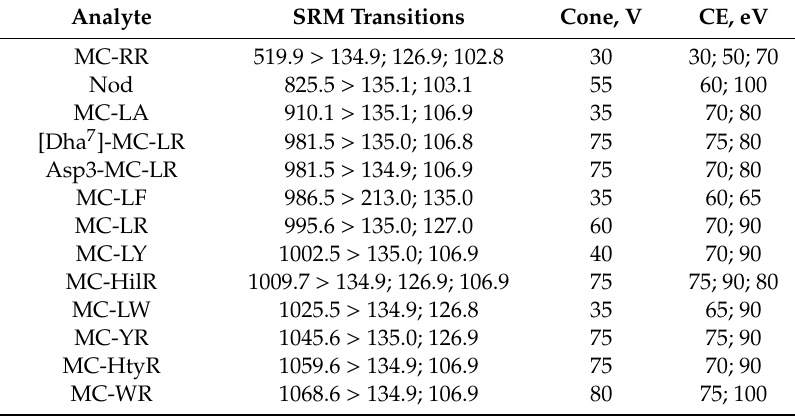
Table 1. Selected reaction monitoring (SRM) transitions used for microcystin (MC) detection and